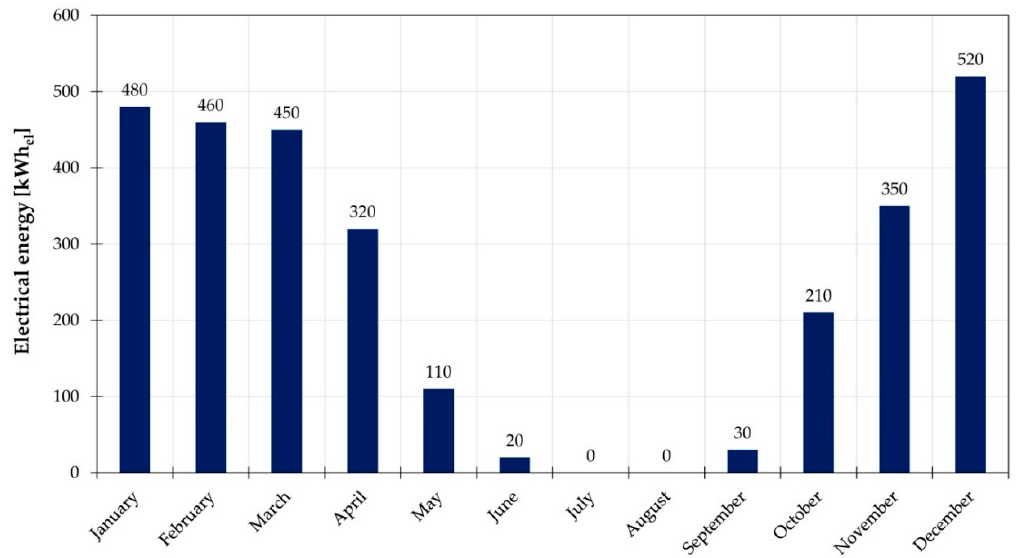
Figure 11. Monthly building electricity energy demand for heating with the ground source heat pump (GSHP) system.